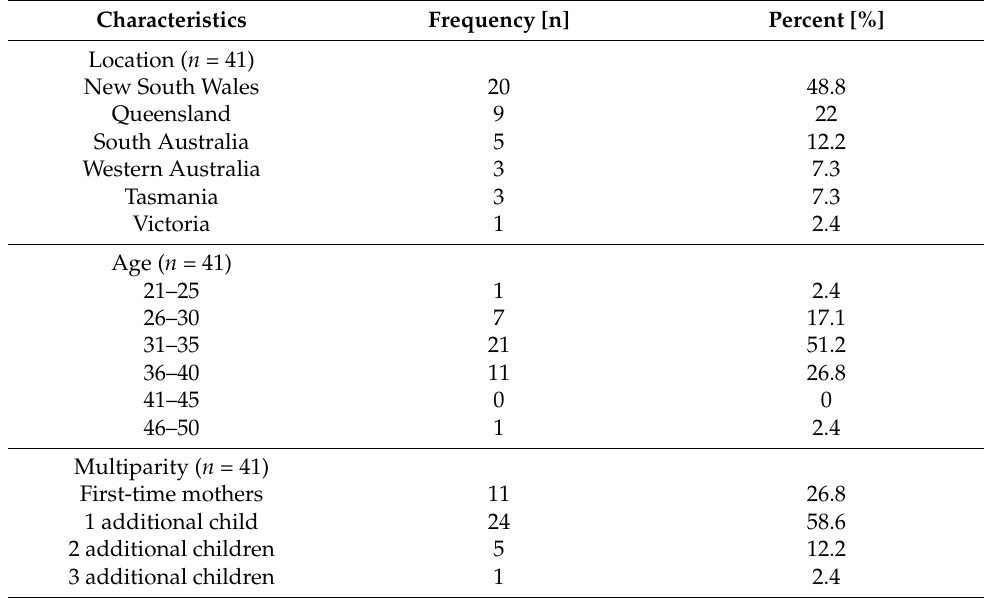
Table 2. Characteristics of women interviewed ( n =